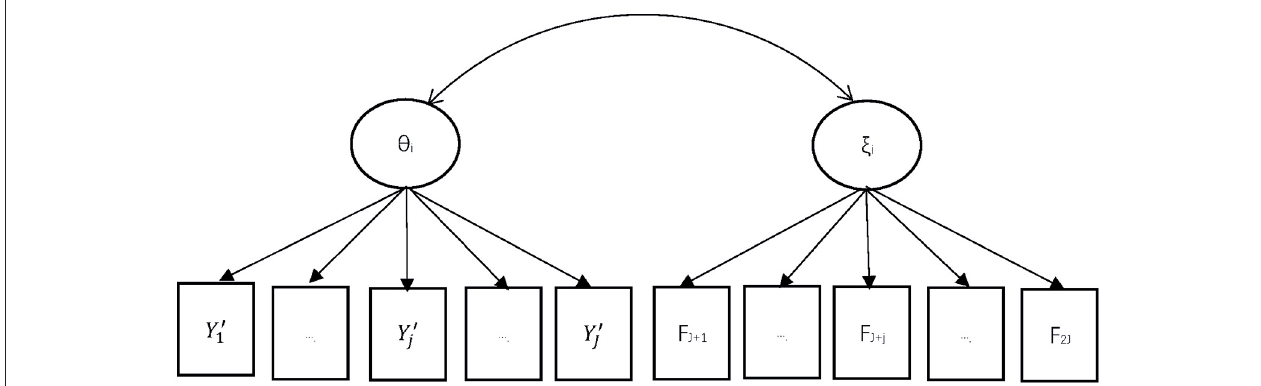
FIGURE 1 | MIRT Approach for Non-effortful Responses. Y j ’ is the response for item j after non-effortful responses were recoded as missing values, where Y j ’ = 1 for correct effortful response, Y j ’ = 0 for incorrect effortful response, Y j ’ = missing for non-effortful responses (j = 1,..., J). F J + j is the indicator for effortful response for item j , where F J + j = 1 indicates effortful response, F J + j = 0 indicates non-effortful response (j = 1,..., J). θ i is the latent variable for the ability of person i (i = 1,..., N). ξ i is the latent variable for the propensity to response effortfully of person i ( i =